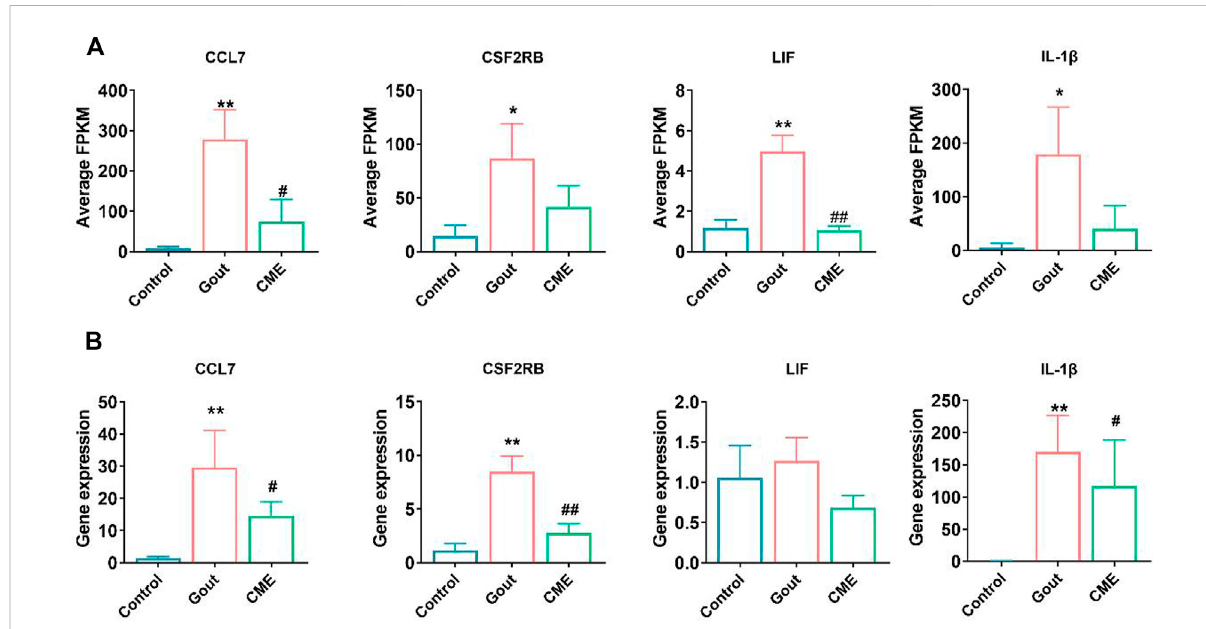
FIGURE 4 Comparison of relative expression levels between RNA-Seq and RT-qPCR results. (A) Detection of expression of four differential genes from RNA-Seq ( n = 3/group). (B) Detection of expression of four differentialgenes byRT-qPCR( n =3/group). Data are expressed as mean± SD (one-way ANOVA), * p < 0.05, ** p < 0.01 vs. Control; # p < 0.05, ## p < 0.01 vs.